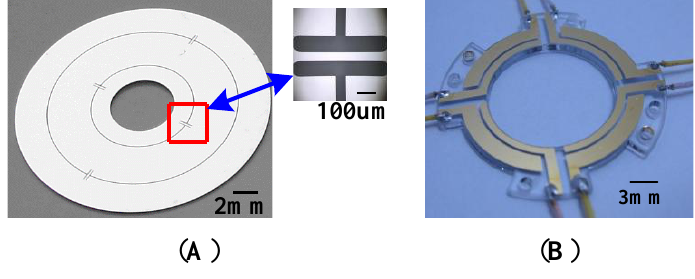
Figure 4. The prototypes of disc rotor module and capacitor plates. ( A ) Disc rotor module. ( B ) Down capacitor plate.